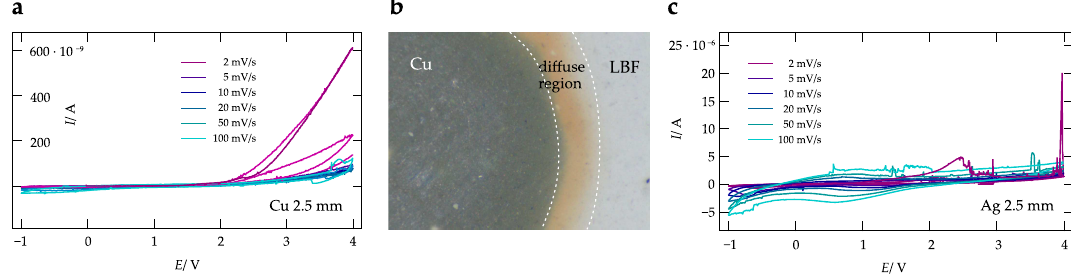
Figure A2. CV of a La 0.9 Ba 0.1 F 2.9 cell with Cu ( a ) and Ag ( c ) as electrode material ( d = 2.5 mm, 0.002 V/s to 0.1 V/s, 200 ◦ C). ( b ) Light microscopy image of a Cu cell ( d = 2.5 mm) after CV. At the Cu|electrolyte interface a diffusive region with orange color appears.